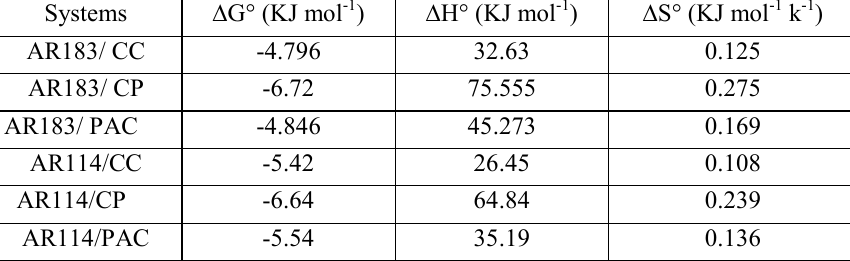
Table 3. Standard thermodynamic constants of AR/Adsorbent